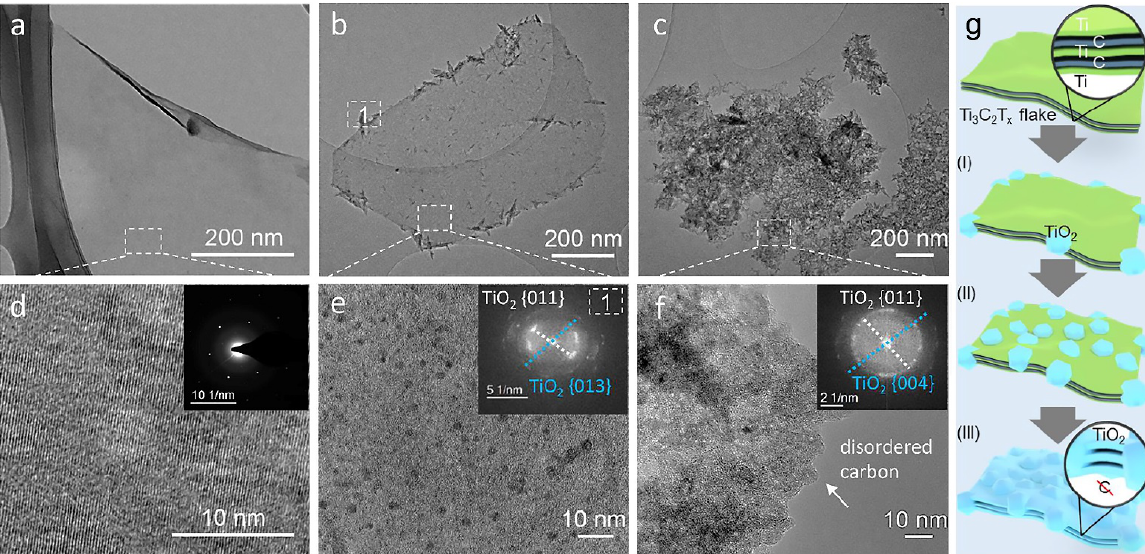
Figure 23. TEM images of Ti 3 C 2 T x MXene nanolayers ( a ) immediately after synthesis and kept in the air at room temperature for ( b ) 7 days and ( c ) 30 days. ( d – f ) High-resolution TEM images corresponding to ( a – c ). Inserts in ( d ) are the electron diffraction pattern of the selected areas, and ( e , f ) is the spatial fast Fourier transform of the images. ( g ) Diagram of the degradation process of a Ti 3 C 2 T x nanolayer: Stage I—formation of TiO 2 at the MXene edge, Stage II—growth of TiO 2 nanoparticles from the edges towards the surface while maintaining the carbon layer, Stage III—etching of carbon by hydroxyl radicals generated by the surrounding TiO 2 , followed by complete transformation MXene to amorphous titanium oxide. Reprinted with permission from [112,113] 2017 American Chemical Society and 2020 American Chemical Society.